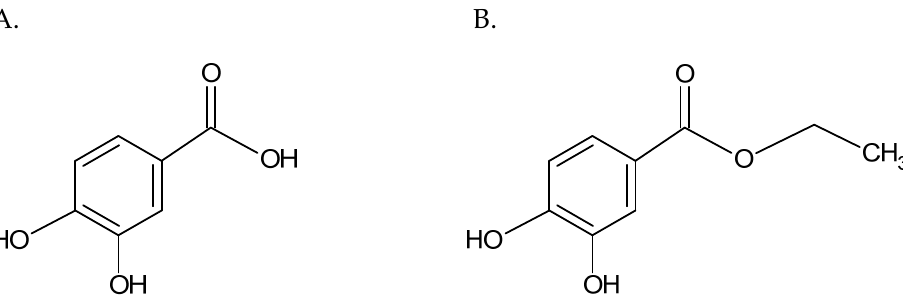
Figure 1. The chemical structure of protocatechuic acid ( A ) and protocatechuic acid ethyl ester ( B ).